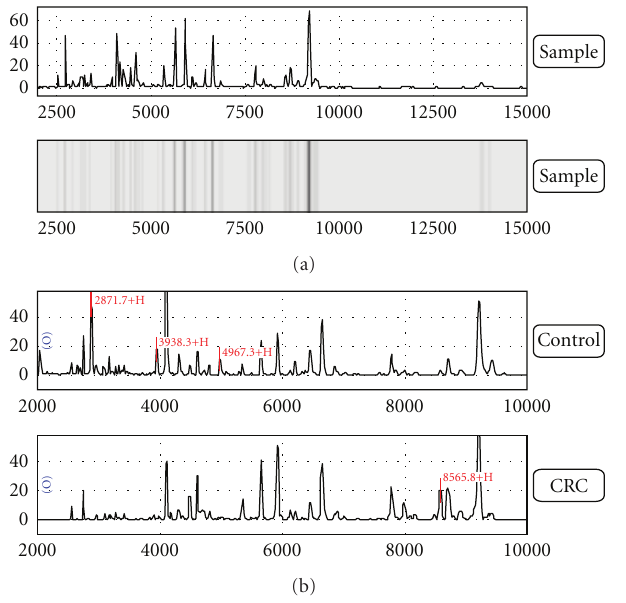
Figure 2: Samples from control and colorectal cancer patients showed di ff erent peaks in proteomics spectrum. Some changes were highlighted.